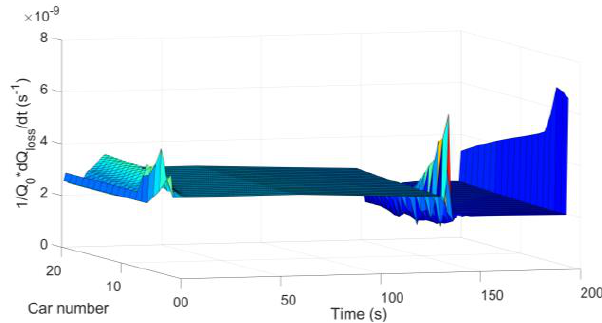
Figure 12. Vehicle battery capacity decline in situation 2.